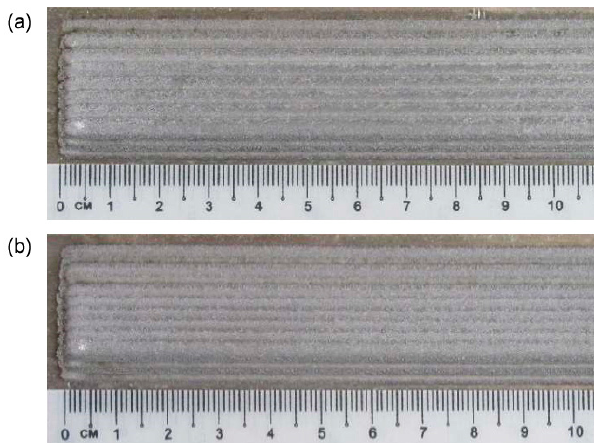
Figure 7. Surface aspects, multi-track, 2-layer deposition: ( a ) 33% OR ; ( b ) 50% OR .